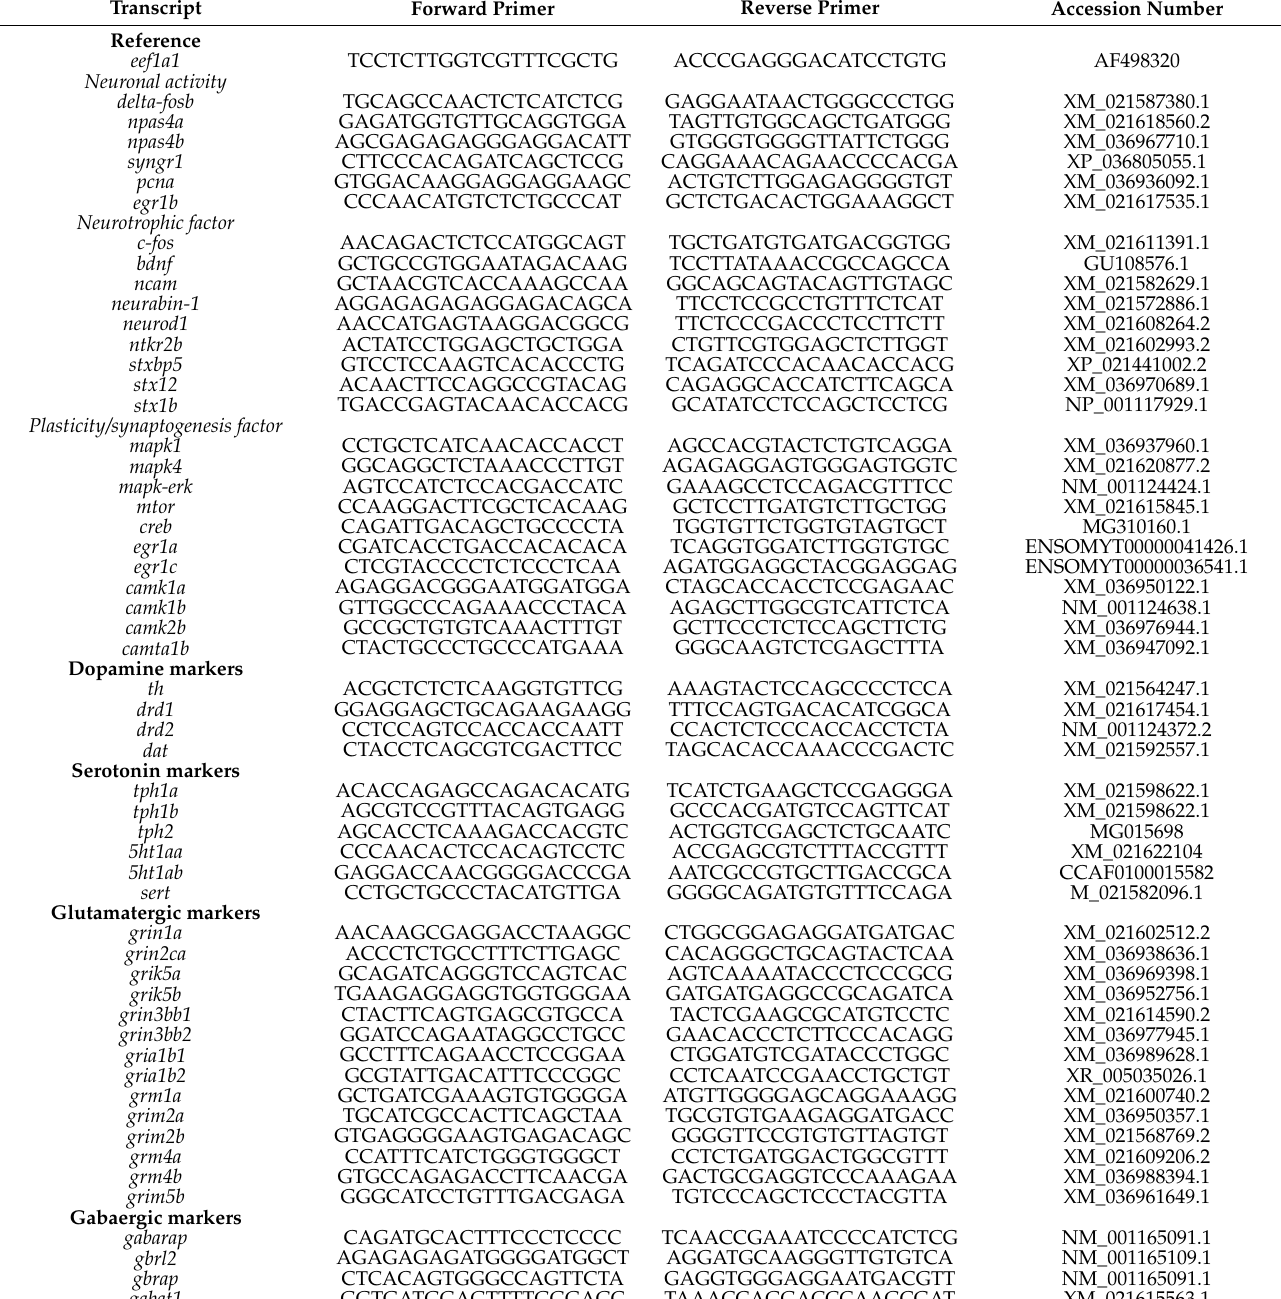
Table 3. Nucleotide sequences of the PCR primers used to evaluate mRNA abundance of genes by RT-PCR (quantitative